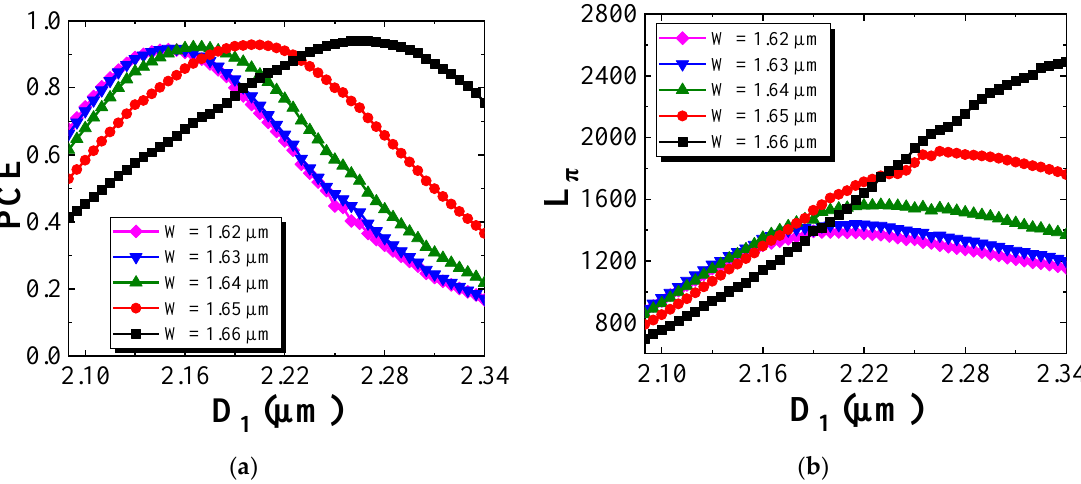
Figure 8. ( a ) Maximum PCE and ( b ) half-beat length, 𝐿 𝜋 , as a function of the shallow etched depth D 1.